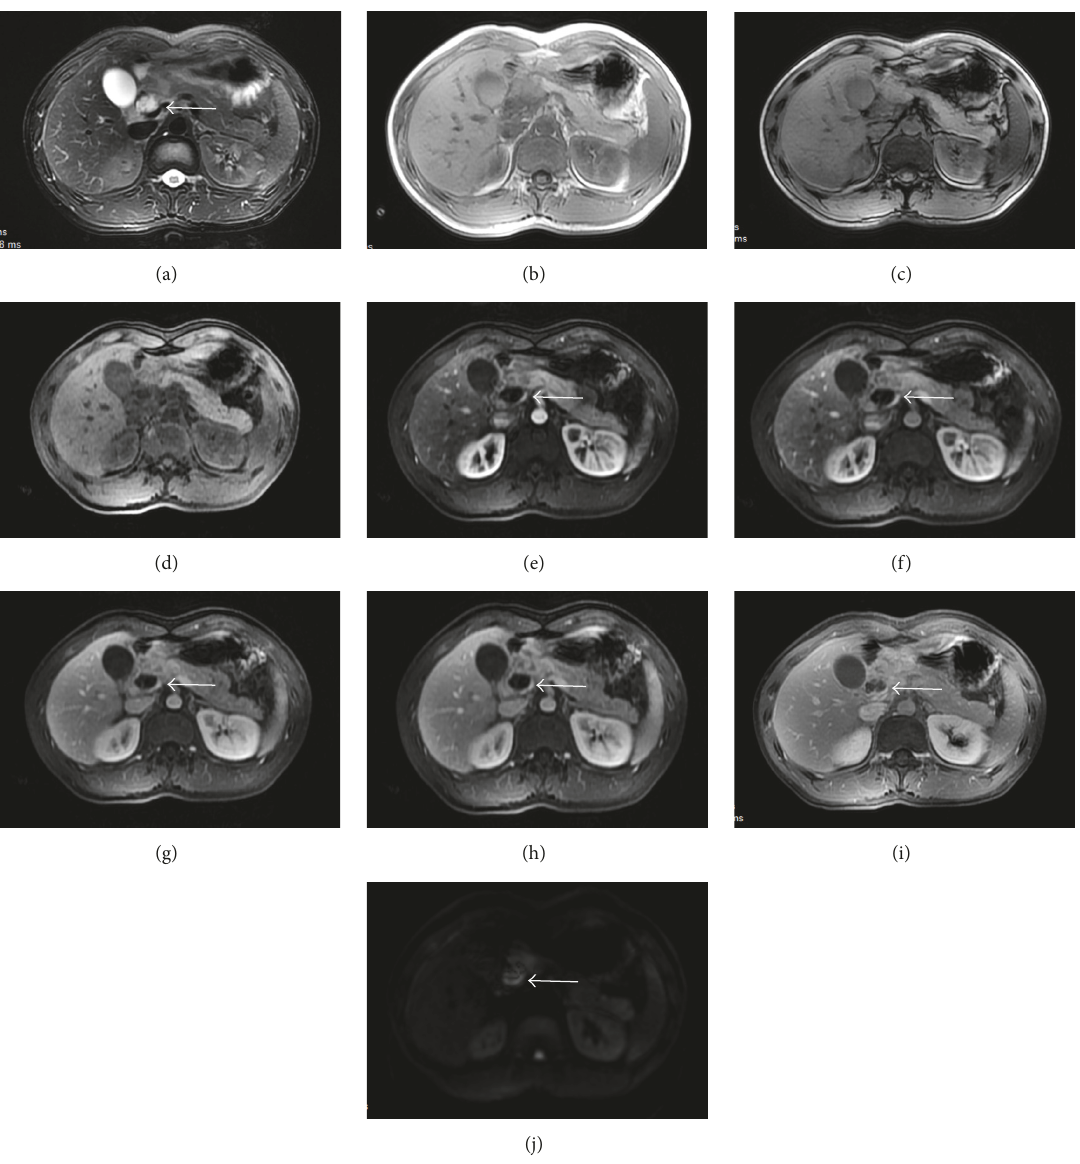
Figure 3: The MRI graph revealed that the head of the pancreas increased with abnormal signal, T2W1 showed a mixed signal, mainly with high signal, T1W1 showed a low signal, positive and negative phase showed no lipid component within the lesion, and DWI showed a high signal which was delayed enhancement unevenly. In addition, there were a slight dilatation of common bile duct and no dilatation of pancreatic duct. T2W1 graph (a), positive and negative phase diagrams (b-c), LAVA prescanned graph (d), LAVA graphs (e–h), delayed enhancement graph (i), and DWI graph